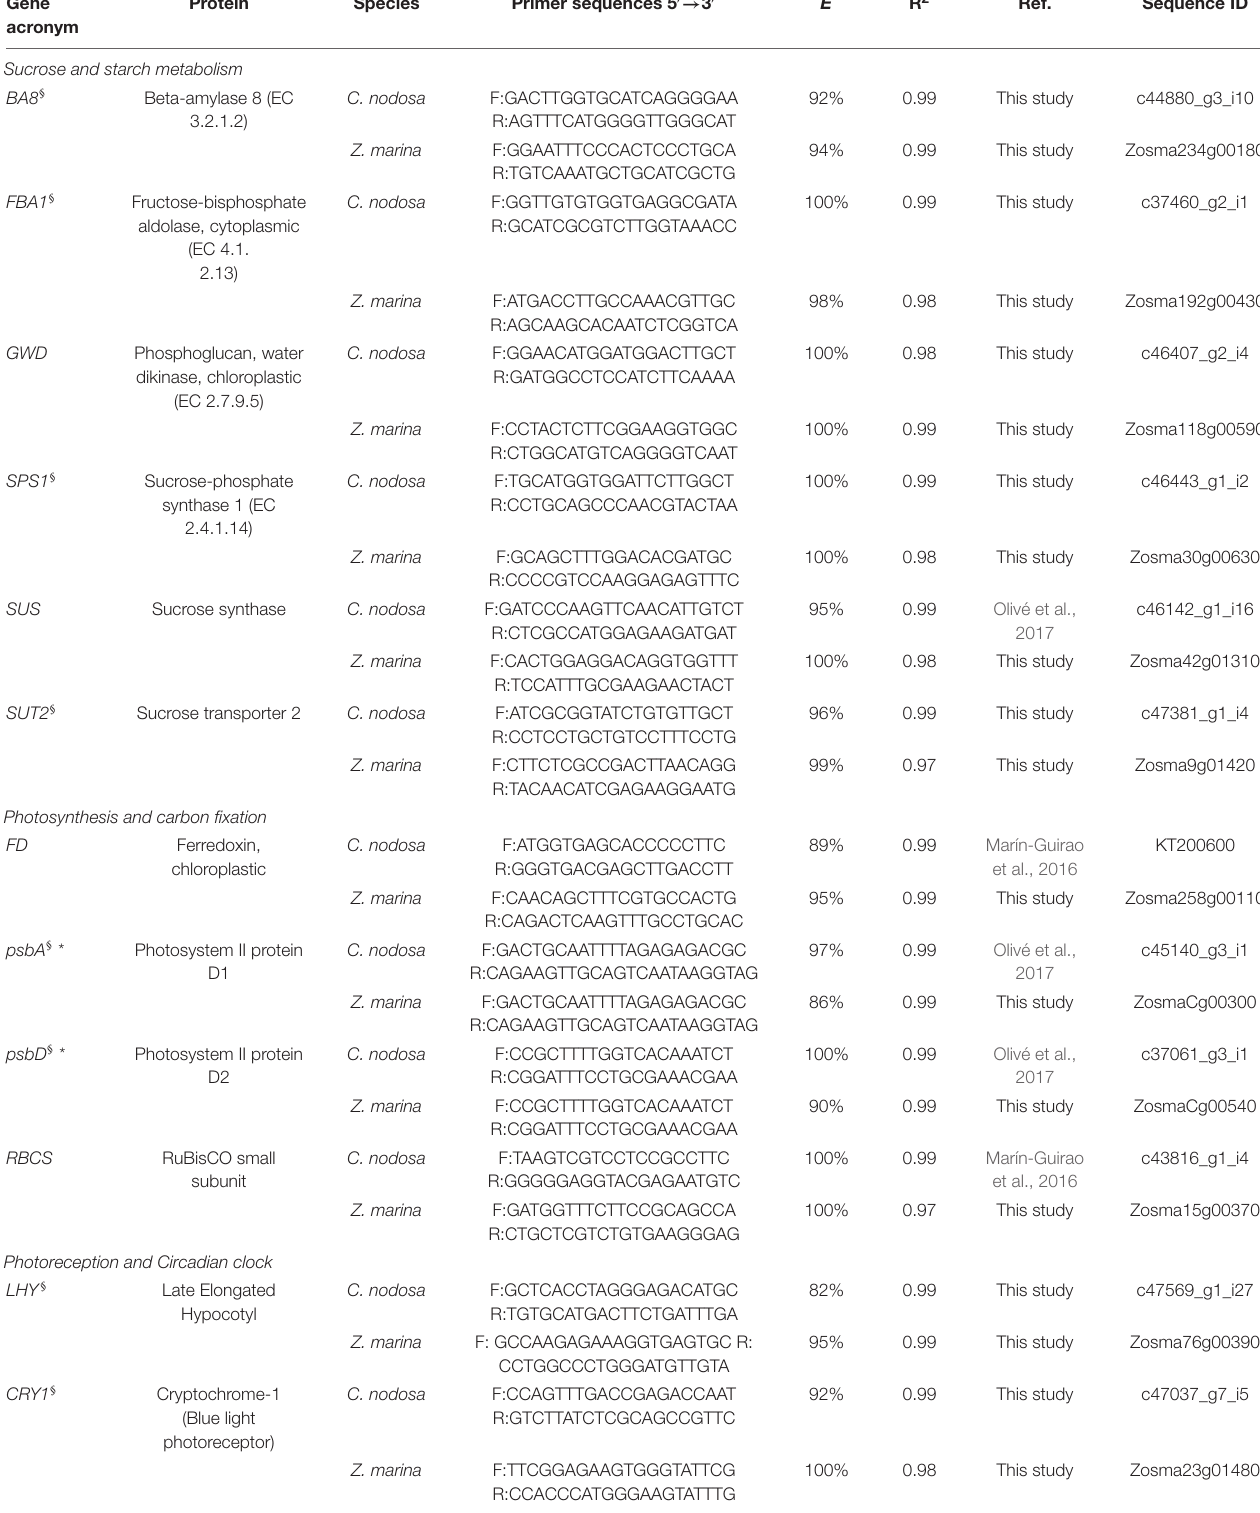
TABLE 1 | List of 19 Genes of Interest in Cymodocea nodosa and Zostera marina targeted by RT-qPCR. Gene